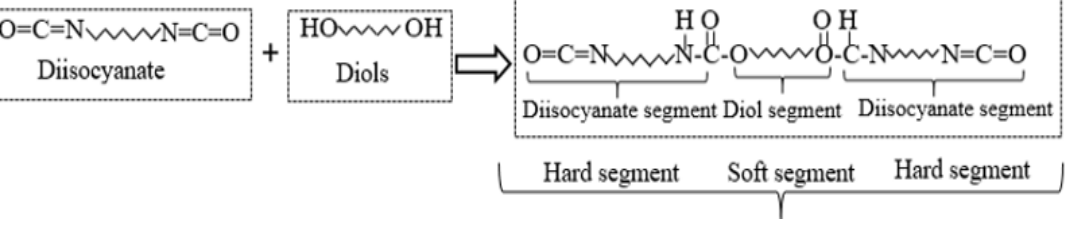
Figure 1. Gradation curve of aggregates. 2.2. Preparation of Polyurethane Composites 2.2.1. PUPC The two polyurethane components, diisocyanate, and PAPI, were combined in a weight ratio of 6:1 with alkylene carbonate acting as a solvent and carefully mixed with a stirrer to obtain a PU binder for the production of PUPC and PUGC composites. Moreo- ver, the CG-431 (defoamer) was integrated with the PU binder to improve its performance. The PUPC specimens were cast for flexural and drop-weight impact tests, using three mixing conditions between aggregate-to-PU binder ratios of 80:20, 85:15, and 90:10 by weight. These aggregate-to-binder ratios were selected following the previous research of Jung et al. [46], Roh et al. [47], and Haruna et al. [42]. The prepared PUPC mixture was poured into the prismatic beam and the U-shaped mold for flexural and drop-weight impact tests. Each U-shaped sample was cast in three layers and tamped adequately to obtain sufficient compaction level following ASTM C138/138M-01a [48]. Then, the PUPC specimens were demolded after 6 h and cured at room temperature for three days. Table 1 shows the formulation of PUPC employed for this